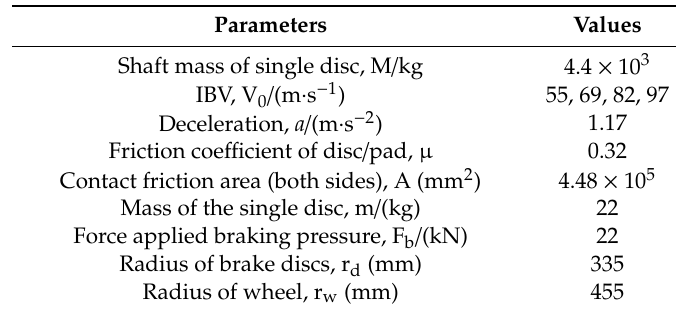
Table 2. Basic data of the brake